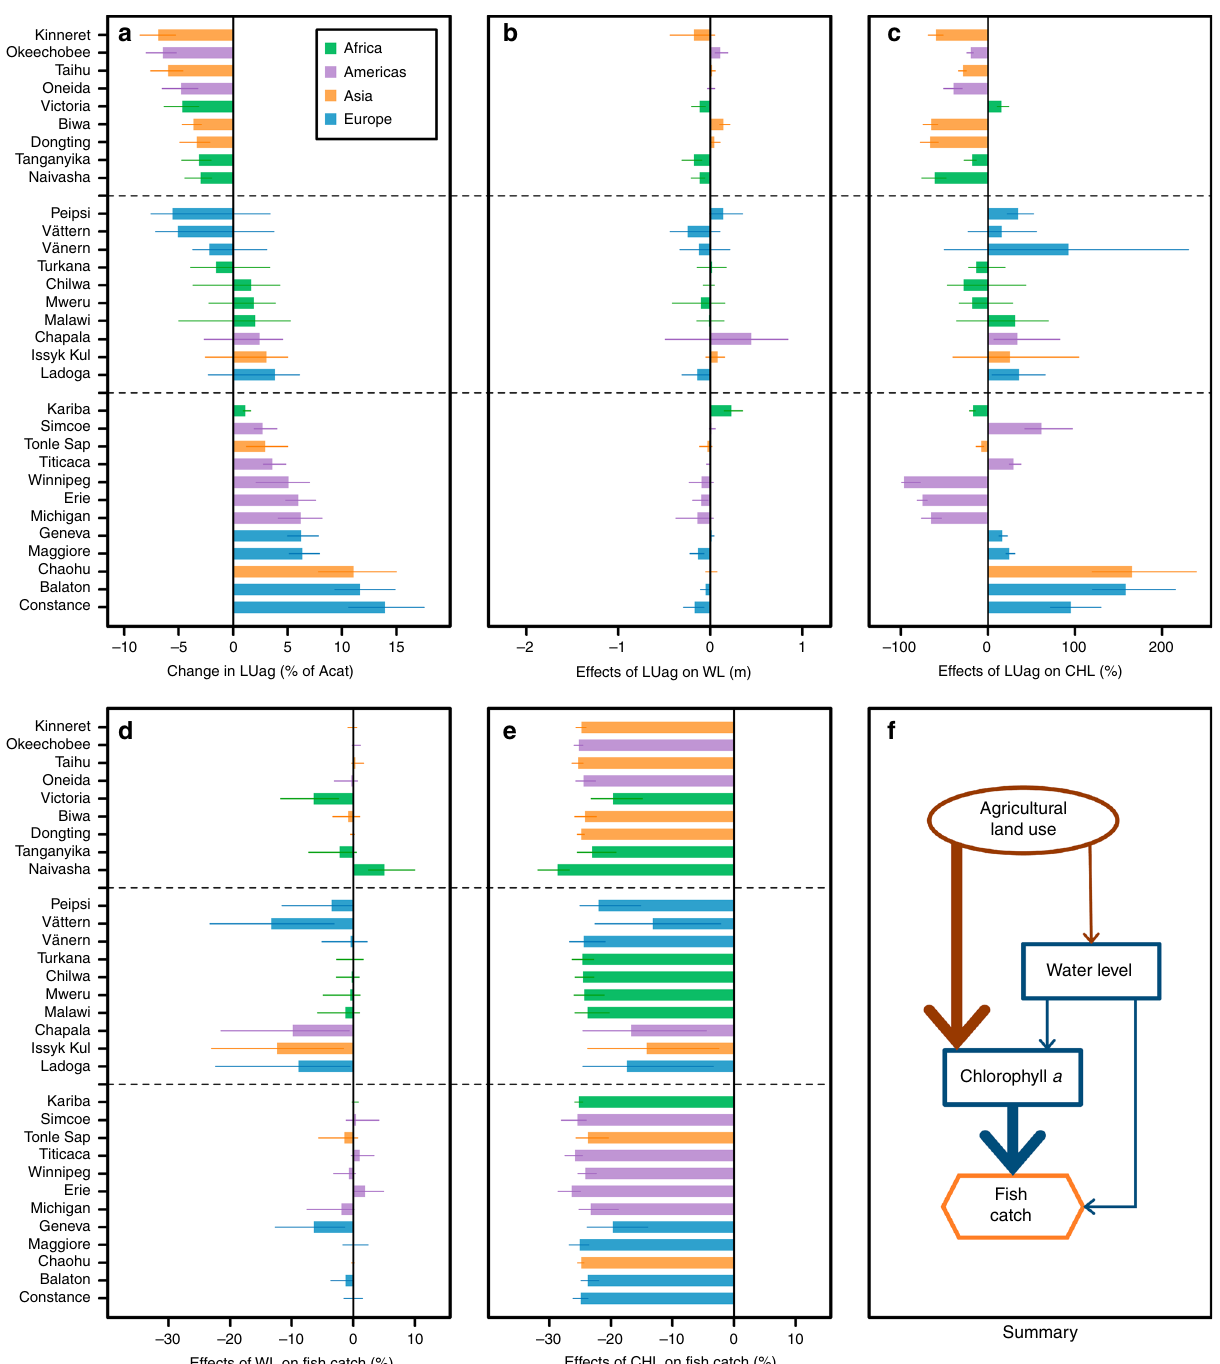
Fig. 6 Assessment for effects of agricultural land use on fi sh catches across the 31 study lakes. Changes or effects were calculated as differences (actual or relative) from the 1970 – 2014 medians. a shows simulated changes in agricultural land use (LUag), in terms of percent of catchment area (Acat), associated with a 25% decrease in fi sh catches. b , c show simulated effects of changes in LUag on water level (WL) and chlorophyll a (CHL). d , e depict how simulated effects of WL and CHL, in response to changing LUag, affected fi sh catches. h summarizes these linkages within a subset of the Bayesian networks model that demonstrates the effects of LUag, where the width of each arrow is a qualitative indicator of the strength of the hypothesized causal effects. In a – e , bars represent simulated median changes and error bars represented fi rst and third quartiles of the simulated changes. Dashed lines divide the lakes into “ positive ” (top 9 lakes), “ mixed ” (middle 10 lakes), or “ negative ” (bottom 12 lakes) associations between LUag and fi sh catches, based on one-tailed 75% credible intervals, as indicated by error bars in a . For positive lakes, a 25% decrease in fi sh catches was associated with decreasing LUag. For mixed lakes, a 25% decrease in fi sh catches was associated with both decreasing and increasing LUag. For negative lakes, a 25% decrease in fi sh catches was associated with increasing LUag. Source data for a – e are provided as a Source Data fi